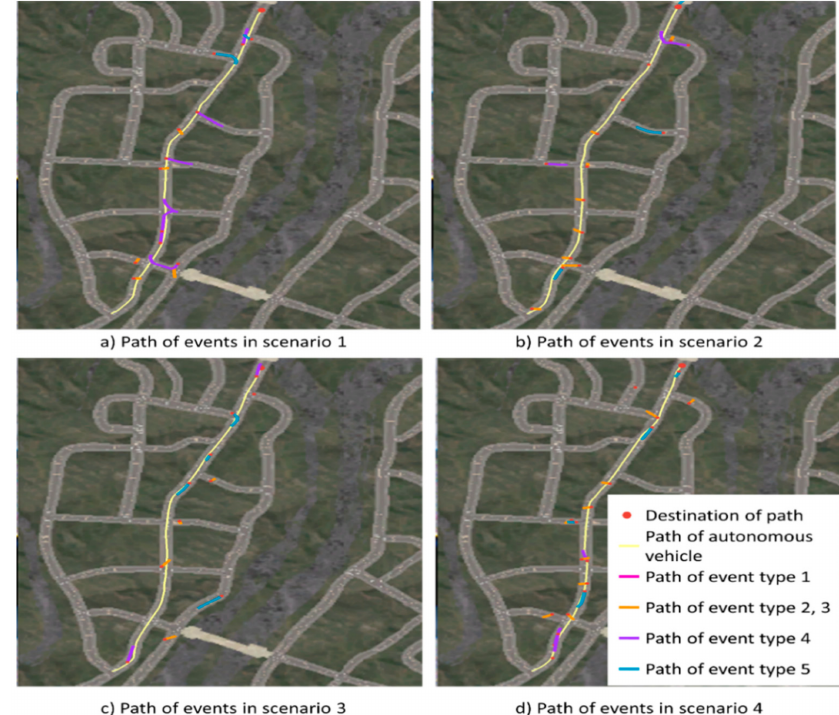
Figure 22. Path of events in four scenarios.